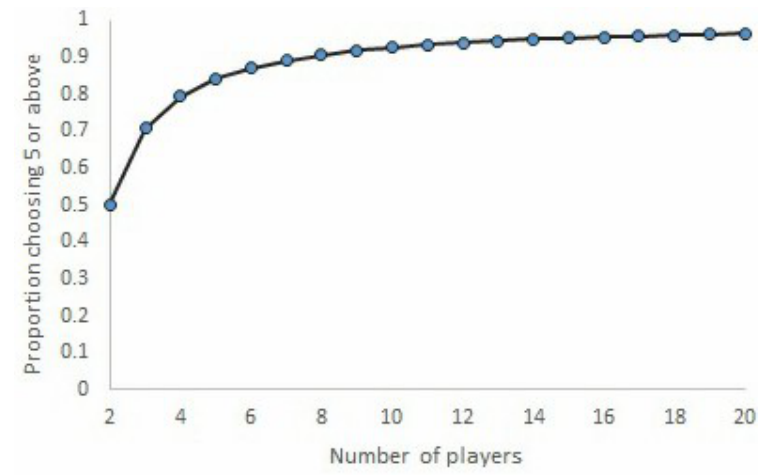
Figure 2. Proportion of players who need to play 5 or more for 5 to be the optimal effort